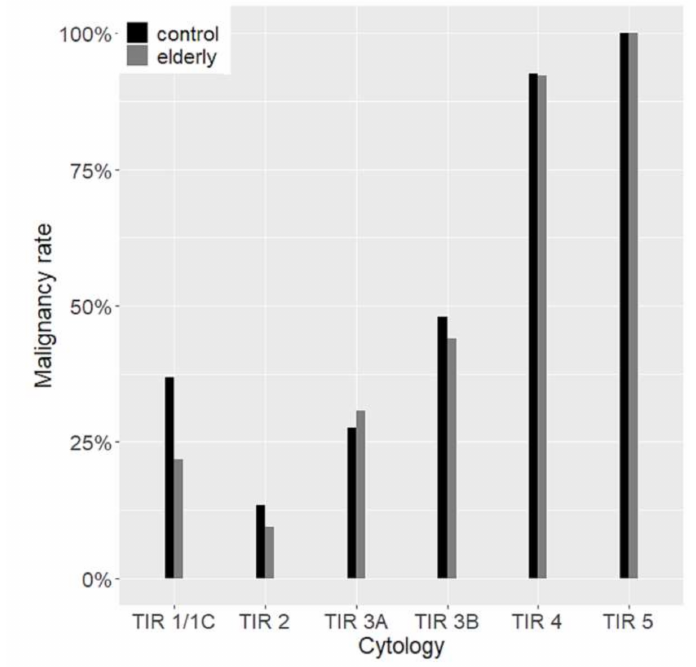
Figure 3. Malignancy rate according to cytological categories. In grey and black are the elderly and the control group